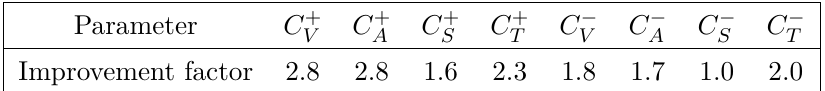
Table 6 . Improvement of the marginalized constraints on the Wilson coefficients of the Lee-Yang effective Lagrangian in eq. (2.2), in the scenario where both left- and right-handed neutrinos are present. The improvement factor is defined as the ratio between the widths of the 68% CL intervals in the fit without and with the mirror data.